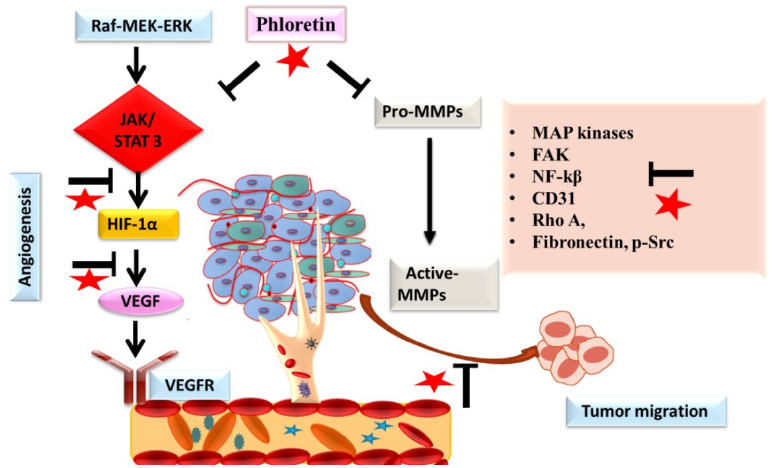
Figure 6. The role of phloretin (as red star) in inhibiting angiogenesis and metastatic spread of cancer cells. Inhibition of the signaling is designated by blockage ( ⊥ )